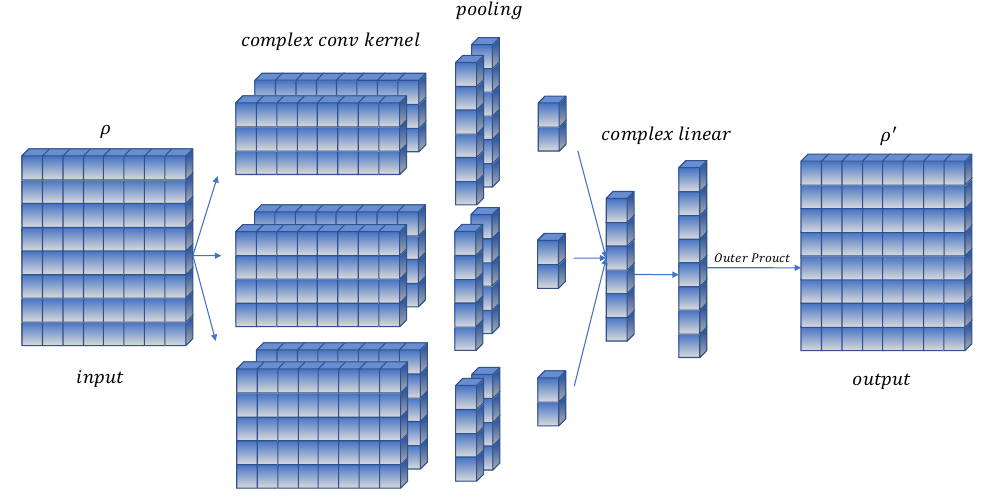
Figure 5. The architecture of ComplexTextCNN.